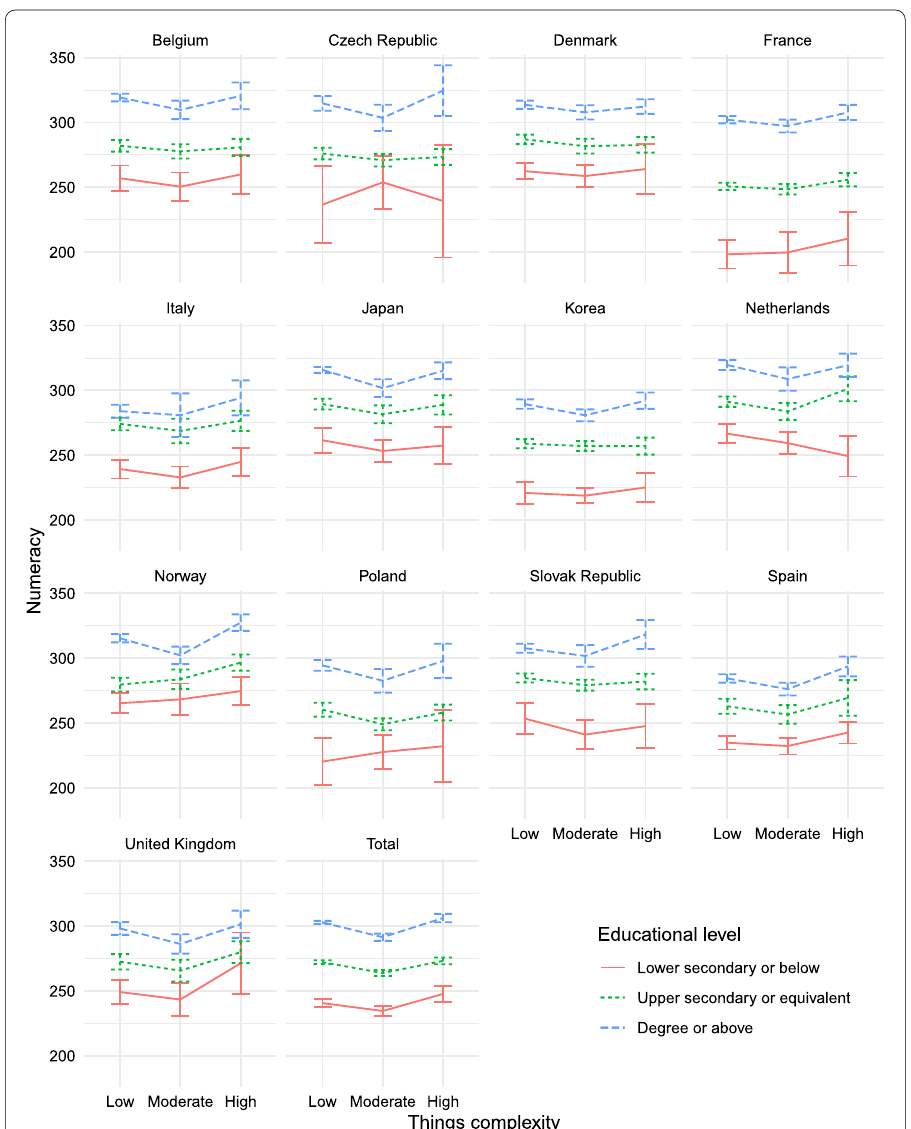
Fig. 4 Relation of complexity with things to numeracy scores among native born full-time employees in age group 25–65 years in 13 PIAAC countries, for each educational level. Error bars depict 95 % confidence intervals. Source: PIAAC 2012, DOT index, ISCO-08